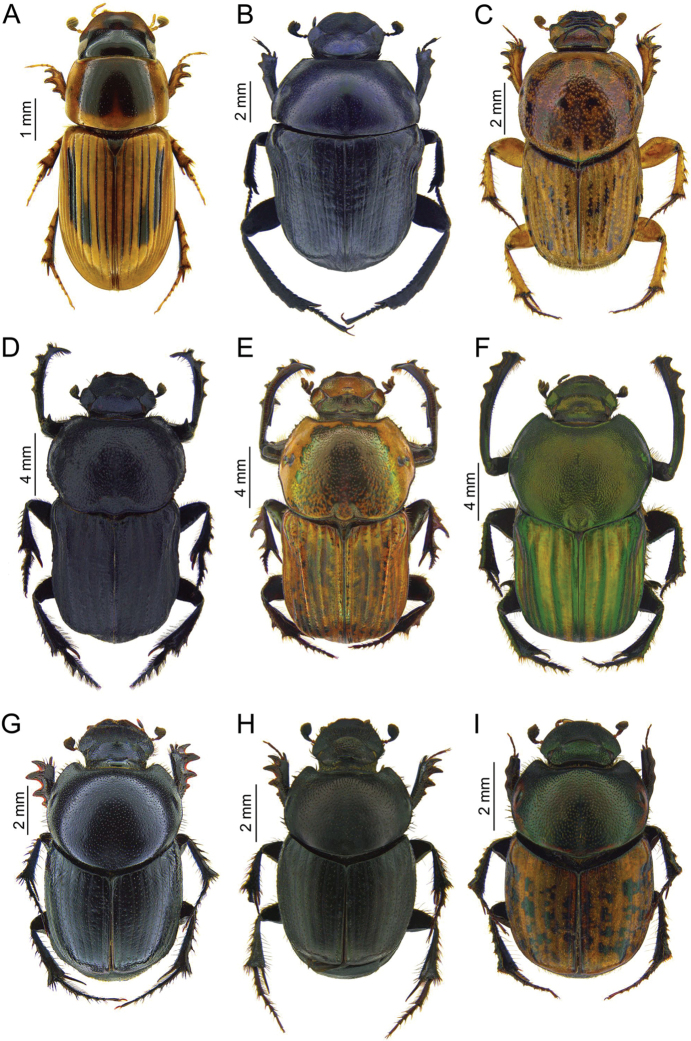
Photos of Scarabaeidae specimens collected during the expedition to Tajikistan in 2014 ANeocalaphodius
moestusBGymnopleurus
aciculatusCEuoniticellus
pallipesDCheironitis
haroldi, male ECheironitis
pamphilus, male FOnitis
humerosus, male GEuonthophagus
sulcicollis, female HOnthophagus
sibiricus, female IOnthophagus
haroldi.